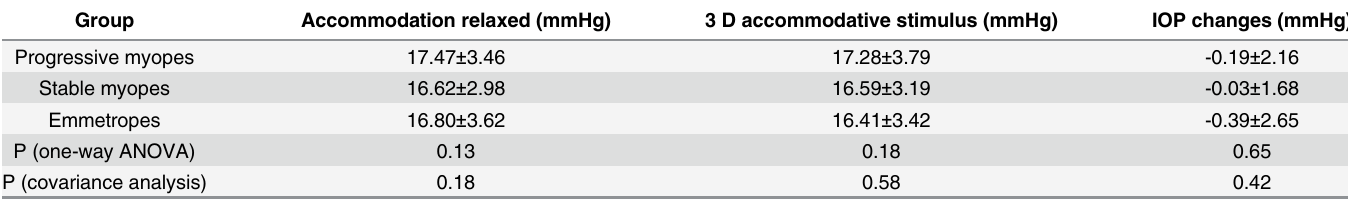
Table 3. The IOP of three groups before and after accommodation.